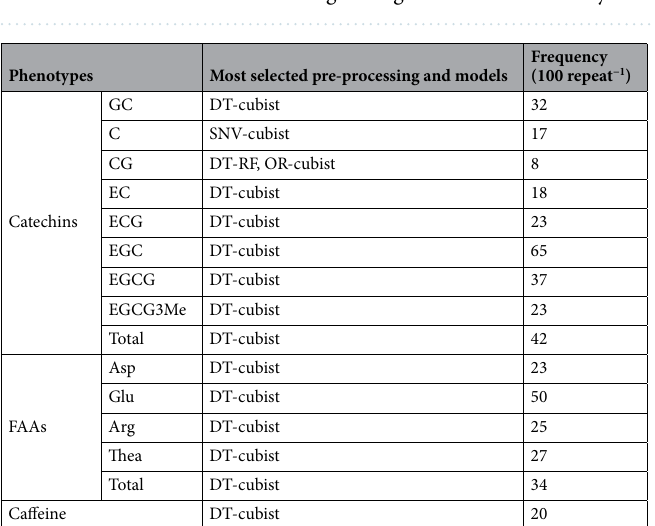
Figure 2. Data distribution of 15 phenotypes for tea quality-related metabolites. Number of samples: 201, 201, and 215 for catechins, caffeine and free amino acids (FAA), respectively. Coefficient of variation (CV) value for each metabolite is included on the Figure. Figures were visualized by the R package “ggplot2” ver. 3.3.2.